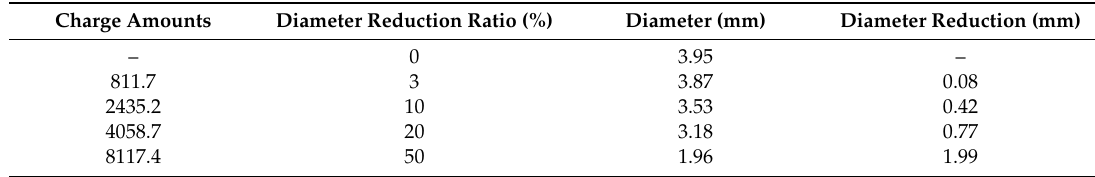
Table 7. Measured diameter reduction of the corroded tensile specimens.